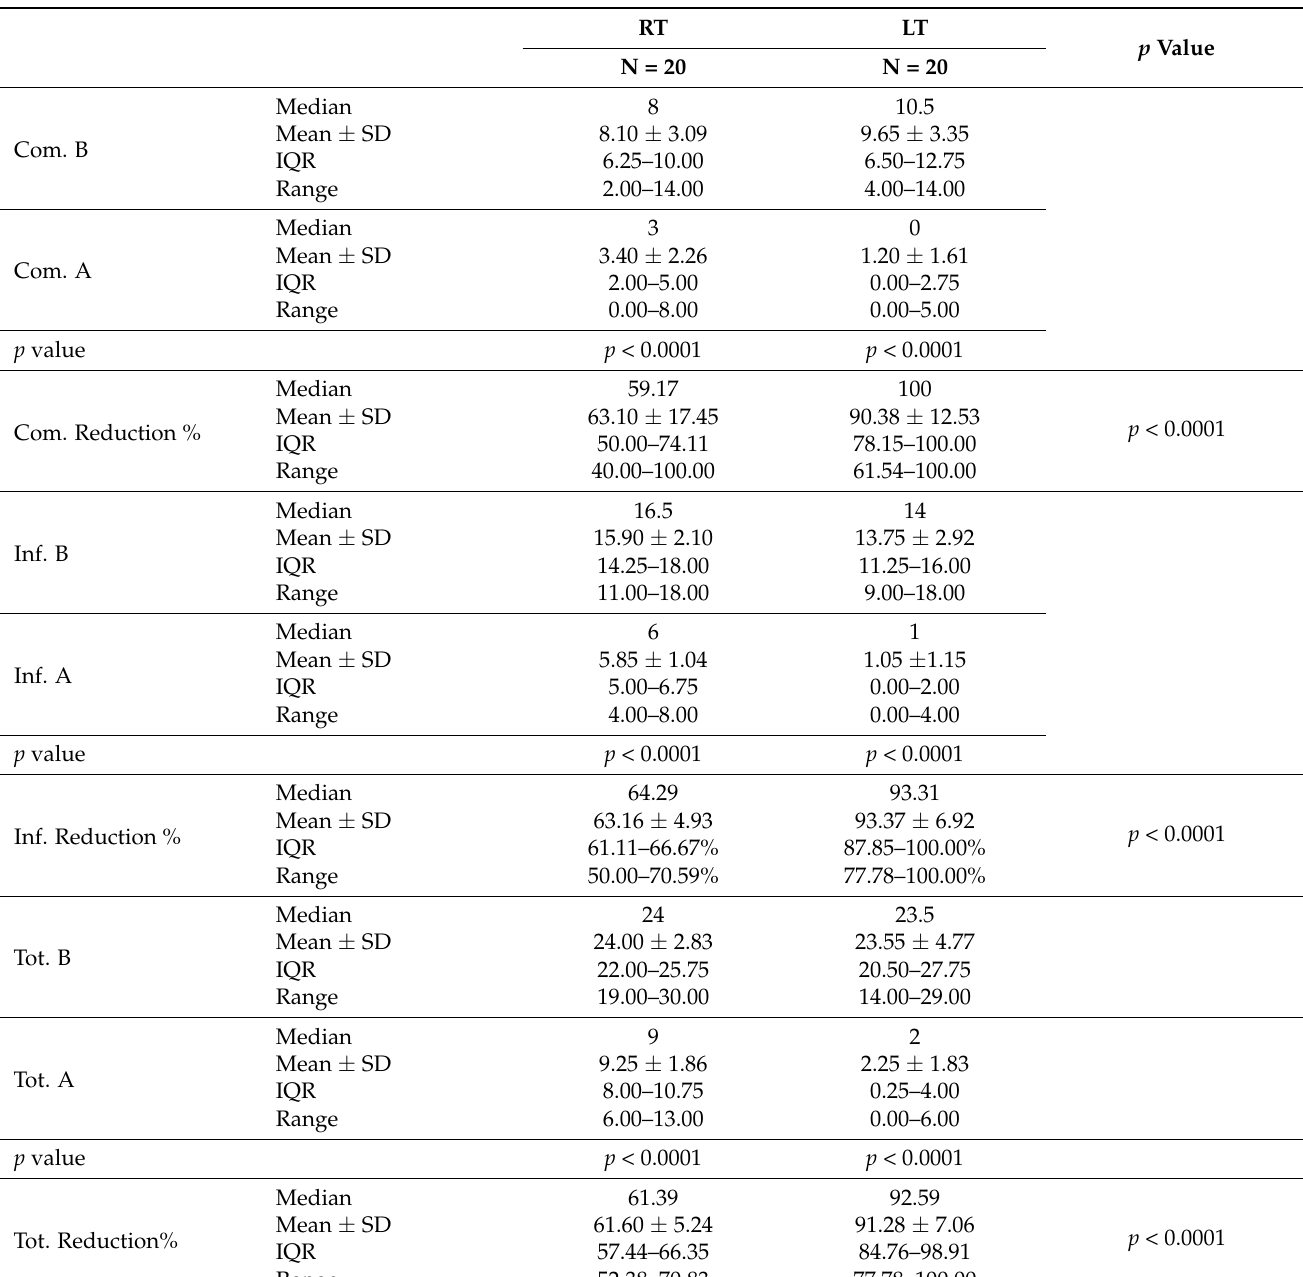
Table 3. The percentage reduction for the comedones, inflammatory lesions, and the total lesions for patients after application of the optimized BEO-NPs formulation on the right side of the face and BEO-NPs-SP formulation on the left side of the face.